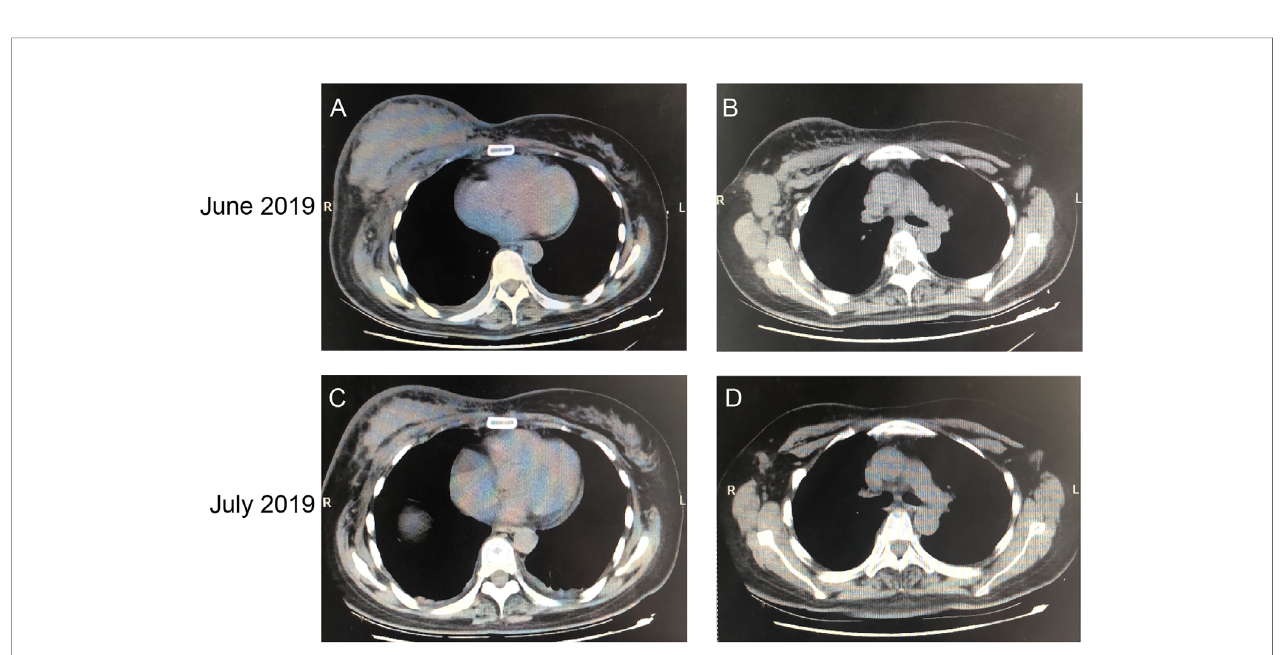
FIGURE 8 | CT Imaging of the breast and lymph node before and after pyrotinib treatment. CT scans before the administration of pyrotinib (images A , B ) and after one month of treatment (images C , D ), showing the tumor mass and lymph